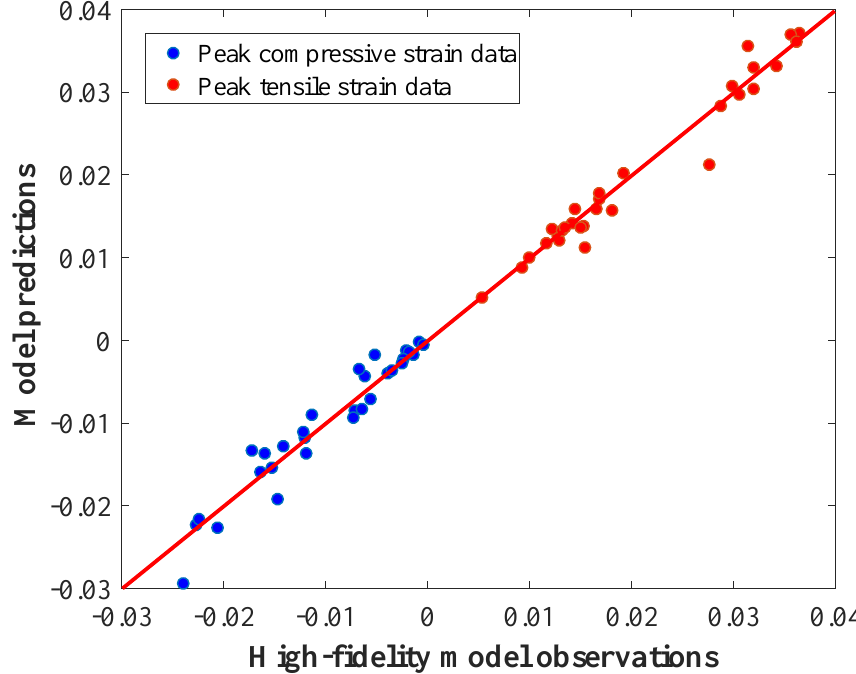
Figure 8. Cross-validation of MF-GP surrogate model for peak tensile strains and peak compres- sive strains.